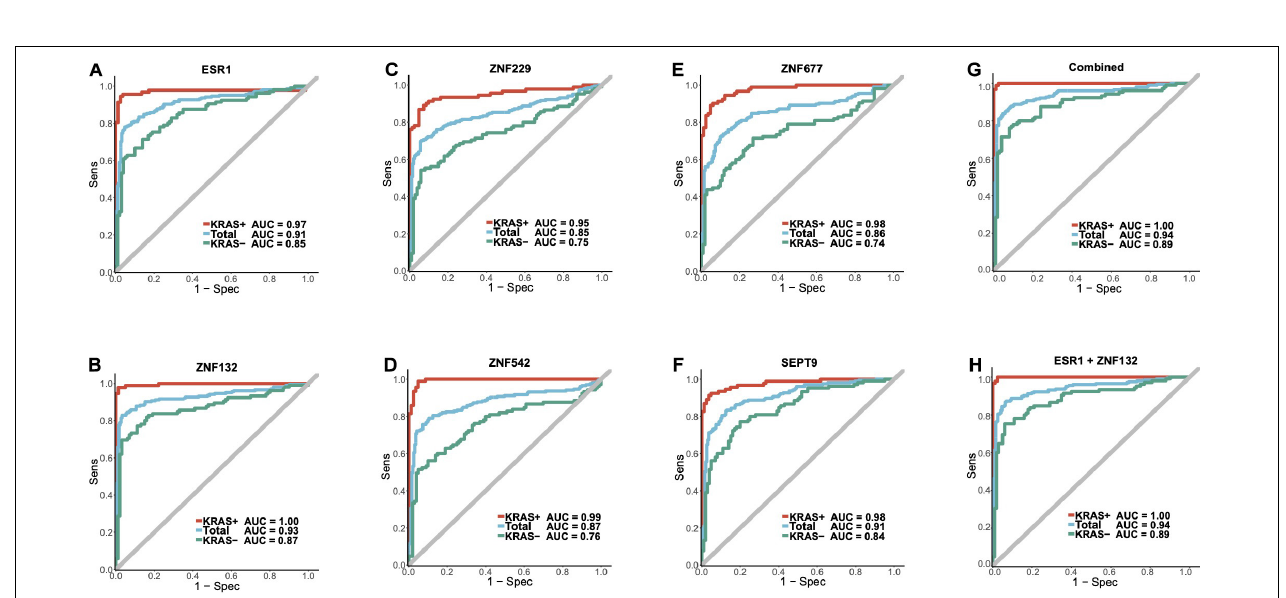
FIGURE 6 | The diagnostic abilities for the candidate biomarkers and ZFGx model in the combined replication cohort. Panels (A–F) represents the diagnostic ability of ESR1 , ZNF132 , ZNF229 , ZNF542 , ZNF677 , SEPT9 individually. Panel (G) represents the ROC curve of the diagnostic model using all five candidate zinc finger genes ( ESR1 , ZNF132 , ZNF229 , ZNF542 , ZNF677 ). Panel (H) represents the ROC curve of the ZFGx model using only ESR1 and ZNF132 as variables. The diagnostic ability of each model for the overall samples, KRAS + and KRAS- subgroups are shown.